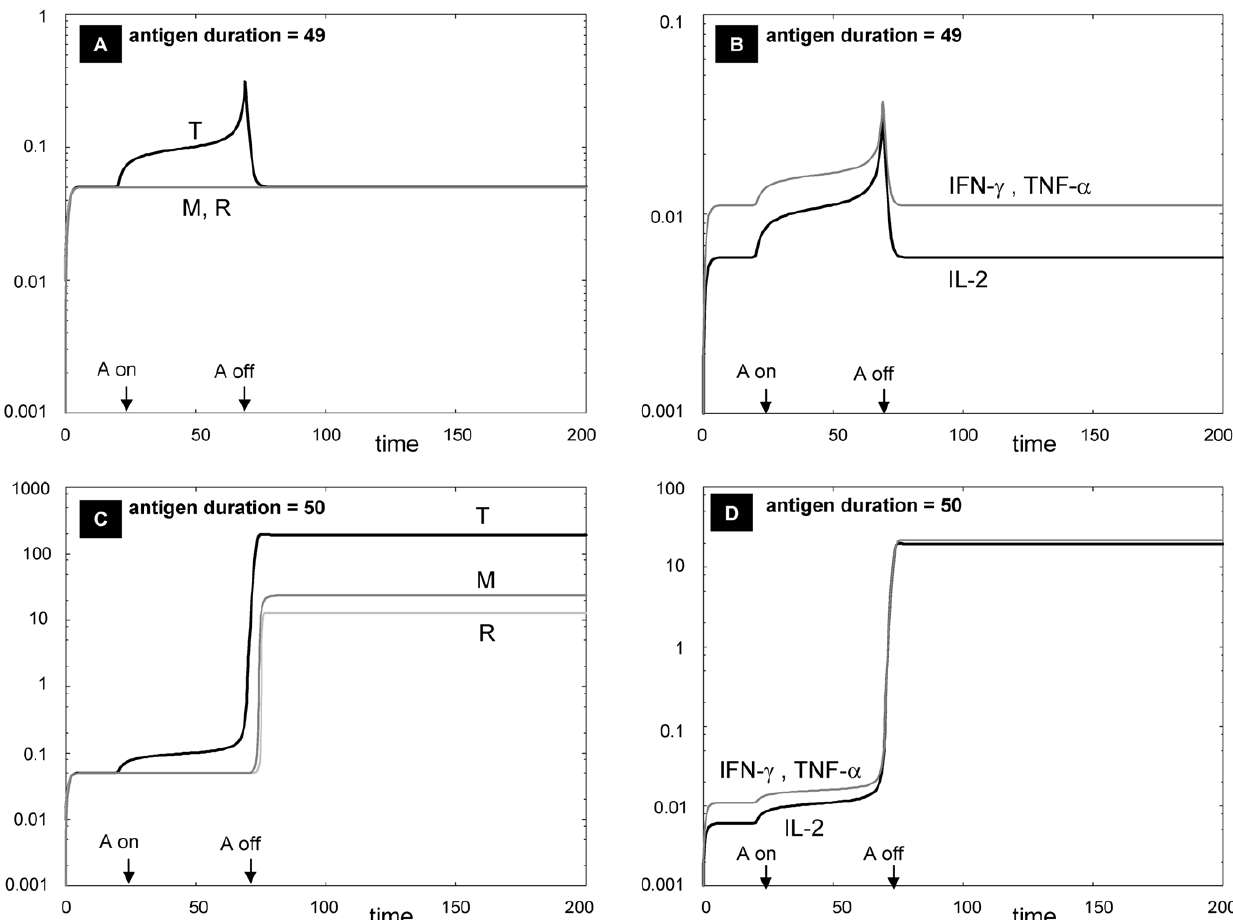
Figure 3. Antigen-dependency of Th1 activity. The detailed model of Fig 2A predicts thresholds of antigen level or duration that trigger Th1 activity. Shown in this figure are the dynamics of the model variables at pre- and post-threshold duration of antigen exposure. The system is first allowed to reach the low steady states of all variables, and then exposed to a square pulse of antigen (with amplitude A=100) from t=20 to t=69 (A and B) or from t=20 to t=70 (C and D) as indicated by the arrows on the abscissa. All parameters as in Table 2, except k 2a =2.1. doi:10.1371/journal.pone.0019544.g003 PLoS ONE |